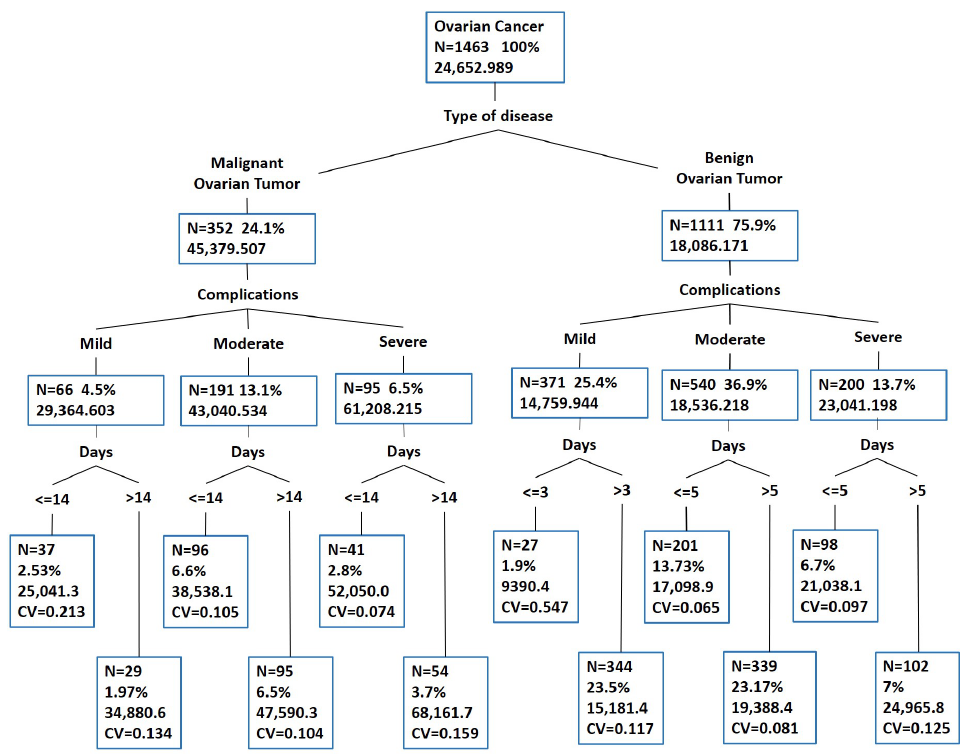
Figure 4. Ovarian cancer case-mix based on the MEDT